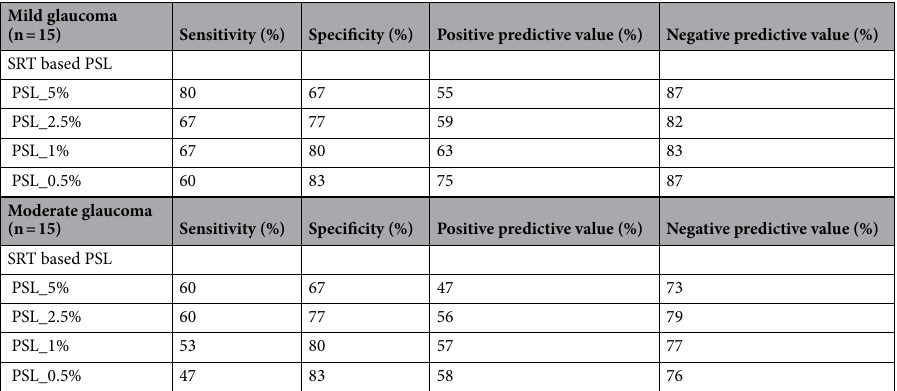
Mild glaucoma (n =